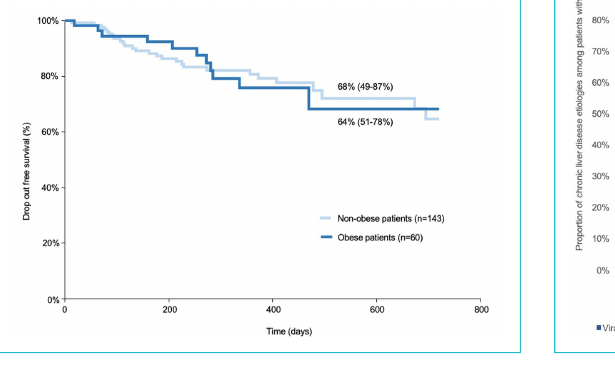
Figure 5: Drop-out curves for obese and non-obese patients over time. The drop-out rate (y axis) over time (x axis) was compared between obese and non-obese patients using the log-rank test and did not differ statistically between the two groups (p = 0.9). Results are represented by a Kaplan–Meier curve. Drop-out includes delisted patients or death while on the waiting list